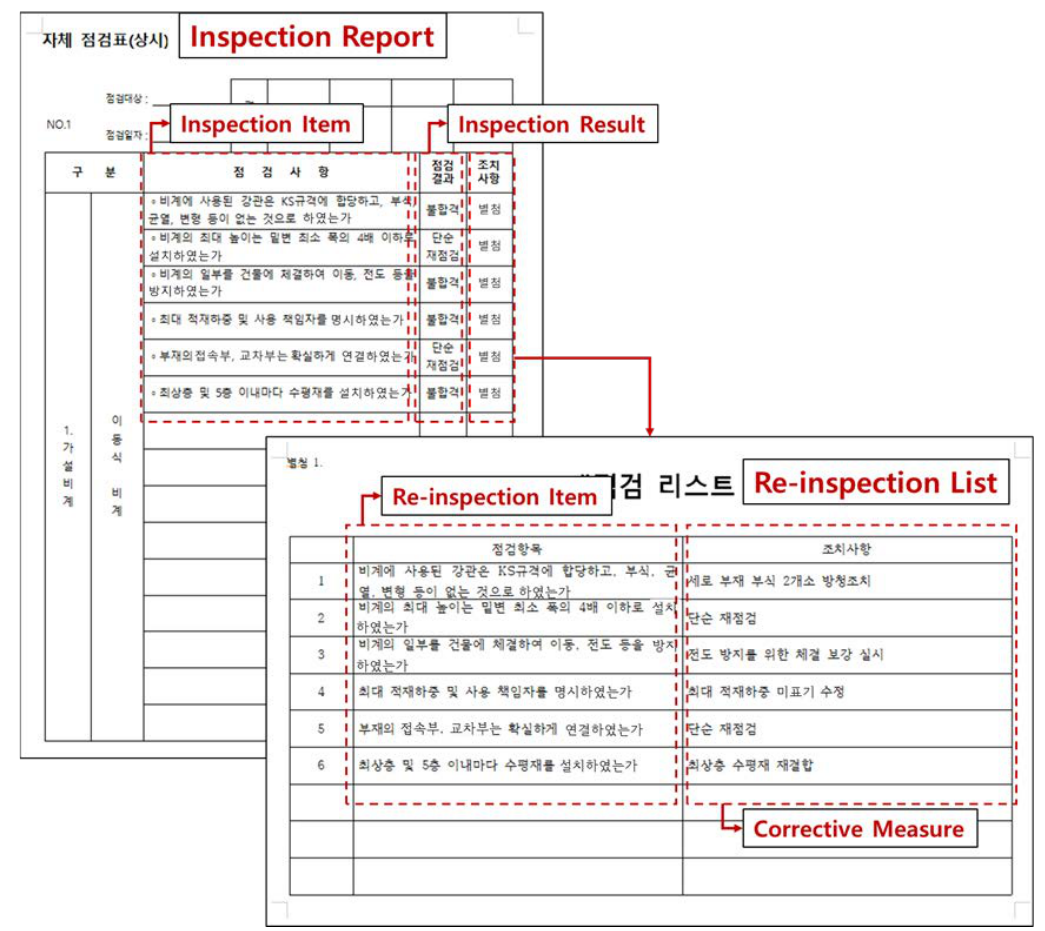
Figure 16. Quality inspection module—quality inspection report